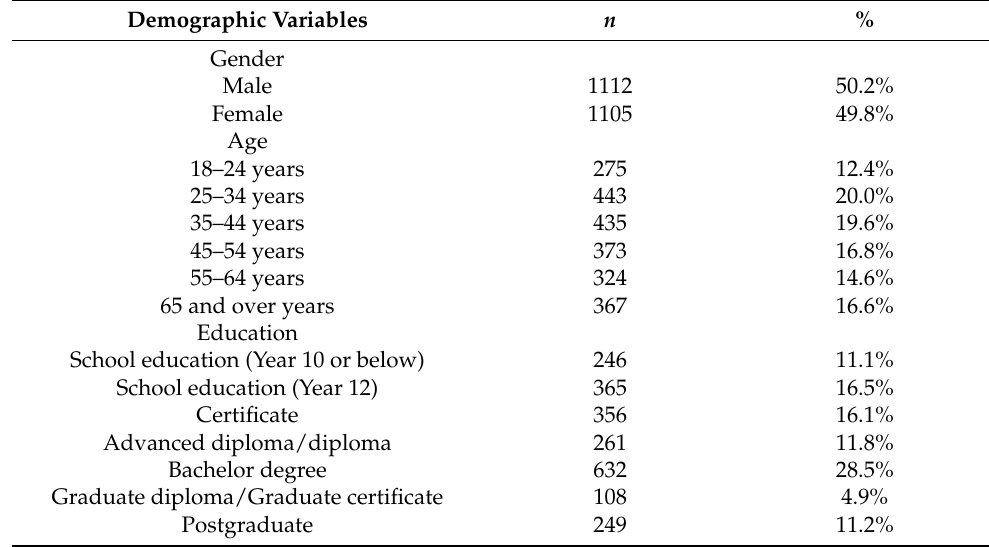
Table 1. Demographic characteristics ( n =